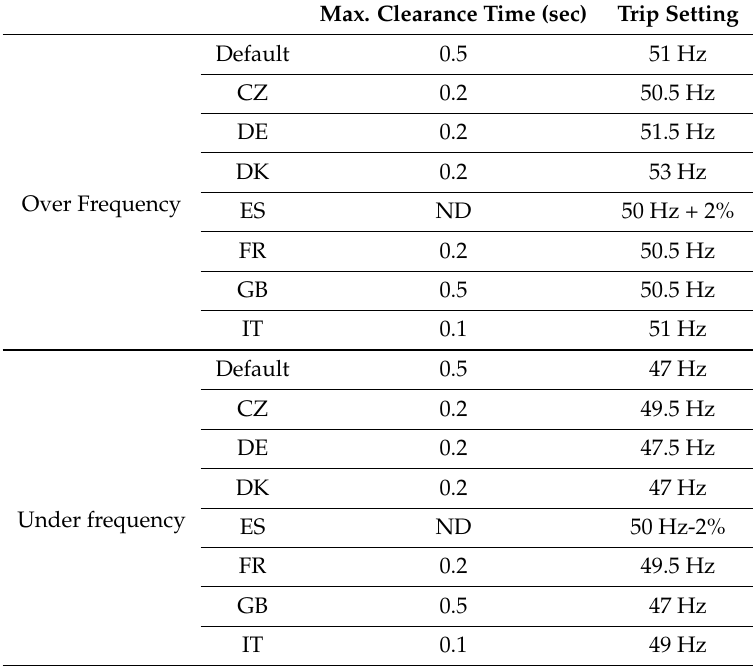
Table A6. Clearance time for frequency deviations.